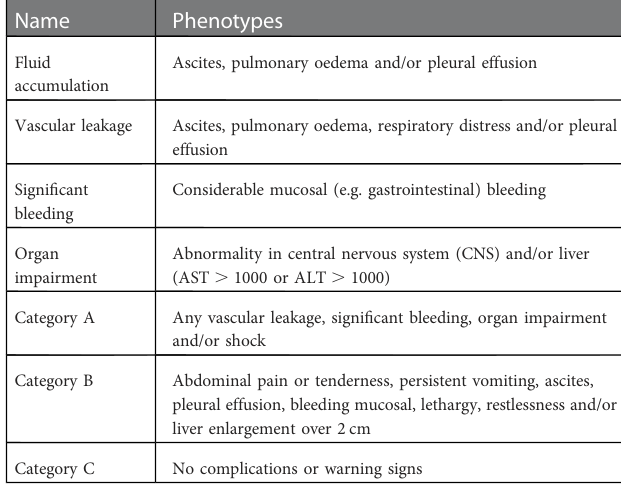
TABLE 2 Compound phenotypes and